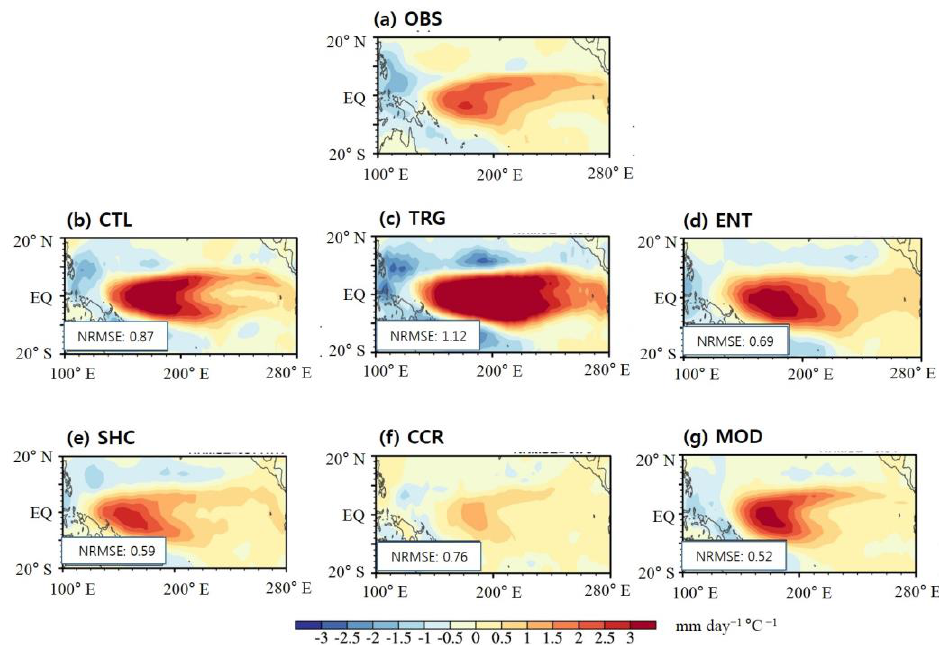
Figure 6. Precipitation anomalies regressed onto Nino-3.4-averaged SST anomalies, all months included (mm day − 1 ◦ C − 1 ) from: ( a ) observation; and ( b – g ) NESM3.0 simulations with the modified parameterizations.